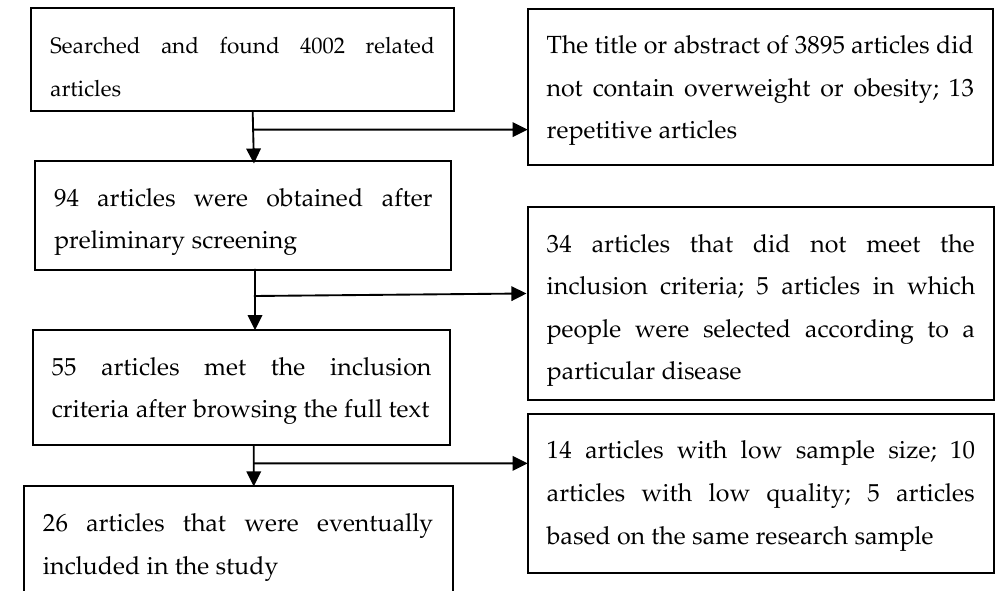
Figure 1. Flowchart of article screening and selection process.